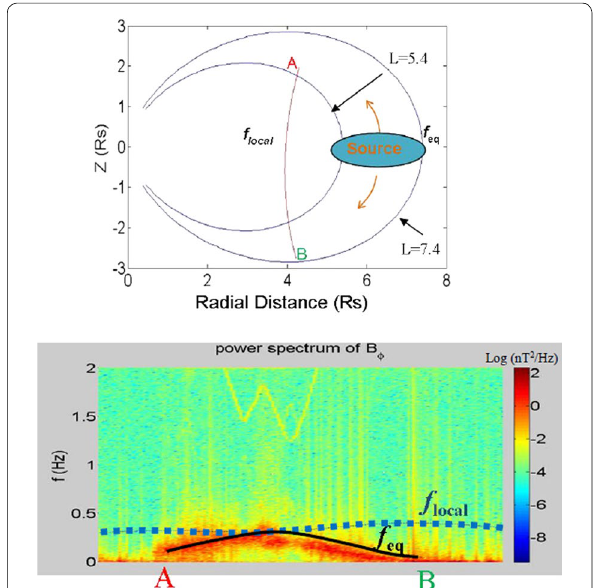
Fig. 7 The upper panel shows the projected orbit of Cassini in the cylindrical R – Z plane across the L -shell from the Northern Hemi- sphere to the Southern Hemisphere. The red line denotes Cassini’s orbit and the blue lines denote the L -shell field lines going through points A and B , respectively. The lower panel shows the power spec- trum of δ B φ , the blue dotted line shows the local W + gyrofrequency ( f local ), and the black line is the W + gyrofrequency at the equator ( f eq ) of the dipole L -shell of the Cassini orbit, which moves from A to B